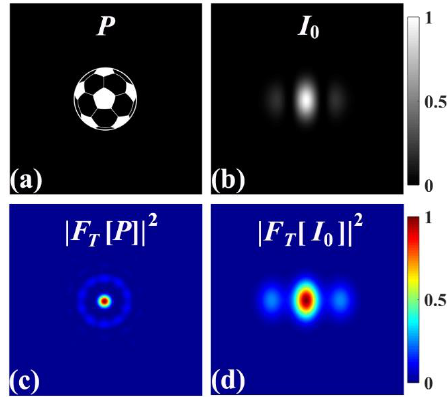
= I  of the 0 0 I . The Fourier transform 0